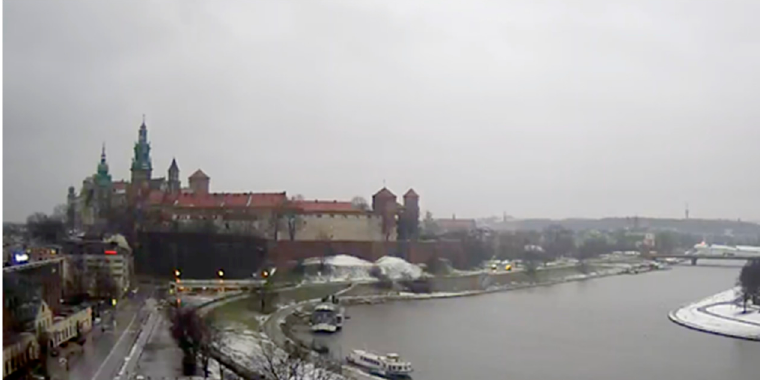
Figure 5. Single frame used in visual inspection of air quality.